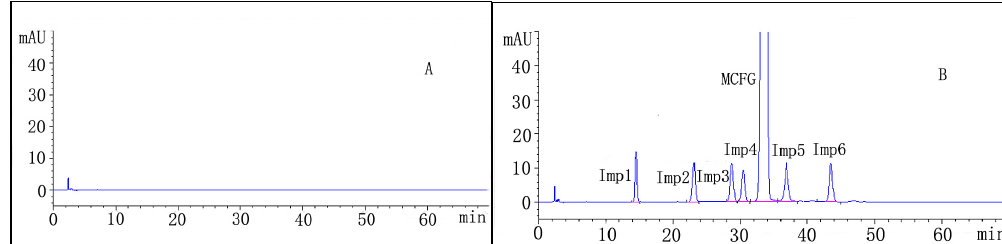
Figure 2. Representative chromatograms of ( A ) diluent, ( B ) micafungin sodium spiked with 0.5% of impurities